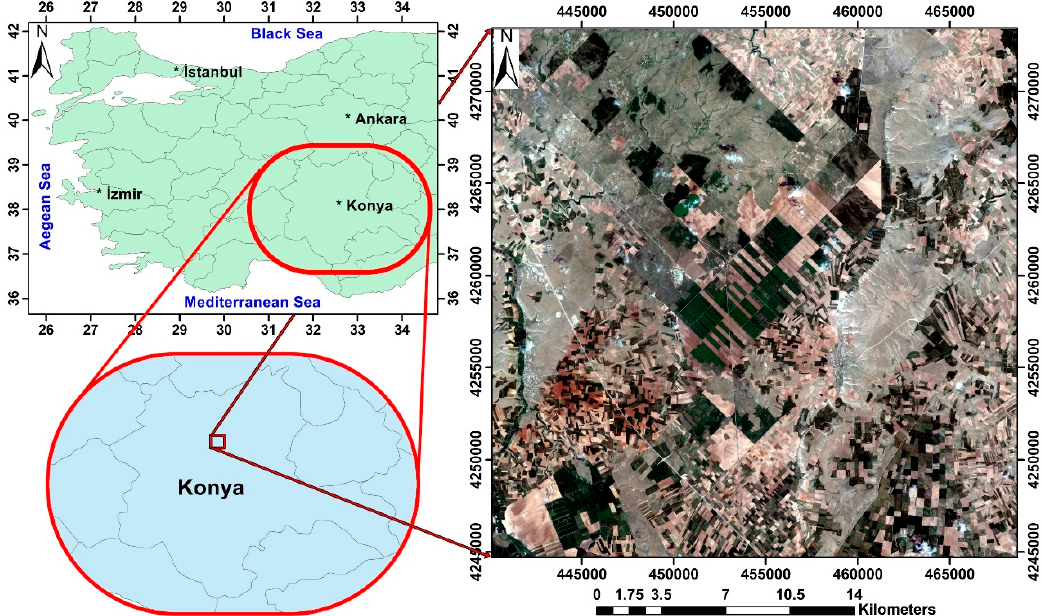
Figure 1. The location map of the study area; general overview (left) and Sentinel ‐ 2 RGB image of the study site (right).